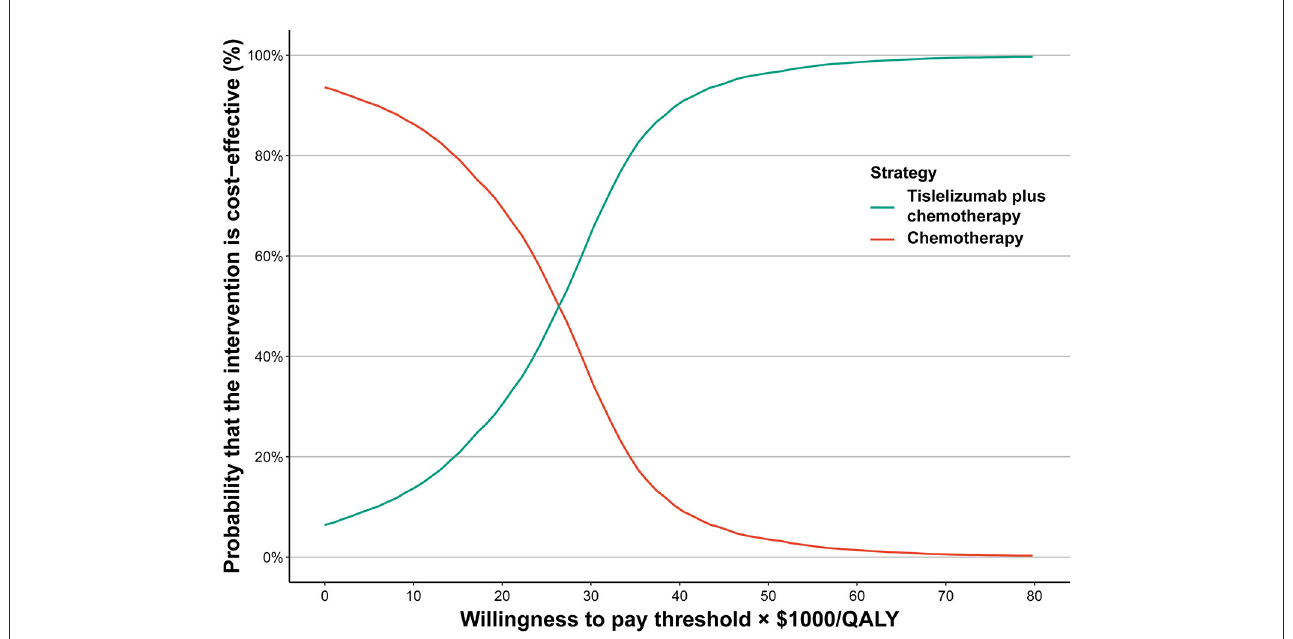
FIGURE1 Acceptability curves of cost-effectiveness. QALY, quality-adjusted life-year.